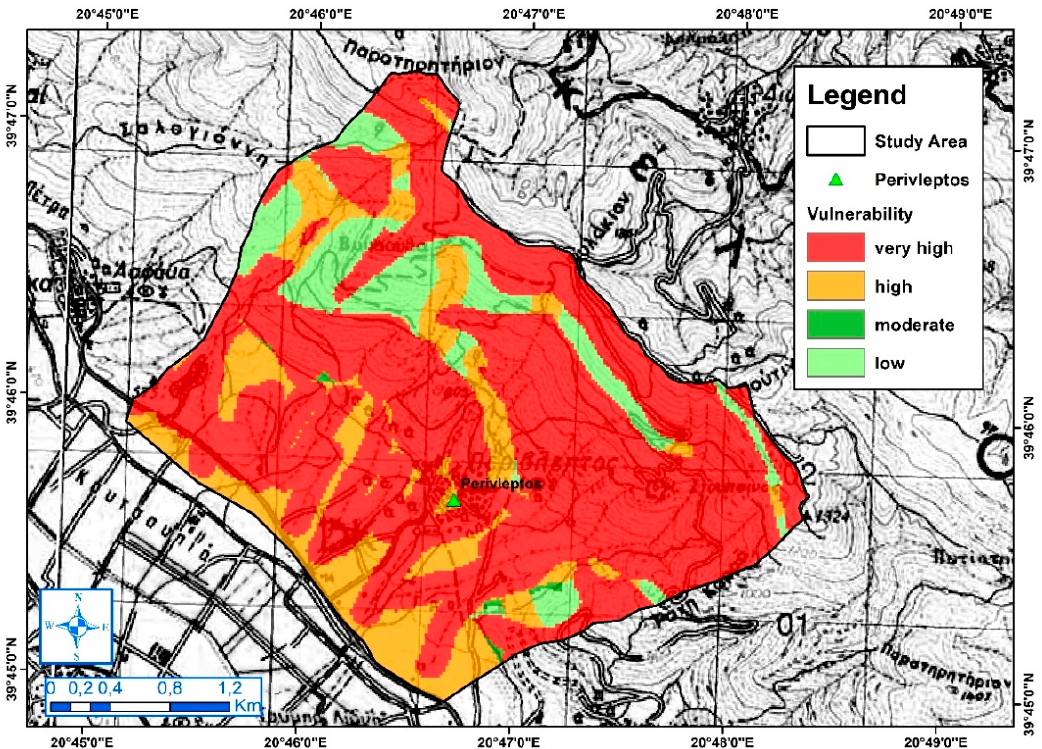
Figure 6. Initial vulnerability map of the study area.